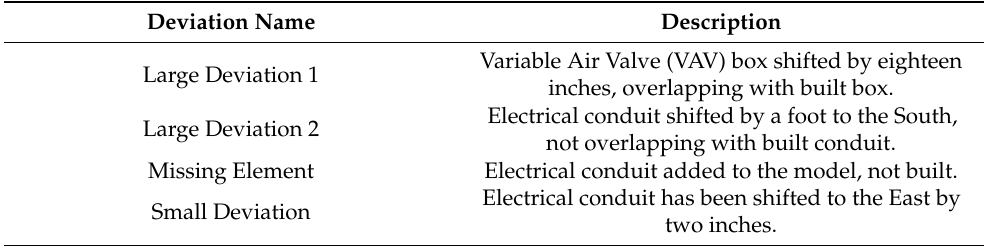
Figure 2. ( a ) Large Deviation 1, ( b ) Large Deviation 2, ( c ) Missing Element, and ( d ) Small Deviation. Table 1. The model deviations and descriptions.